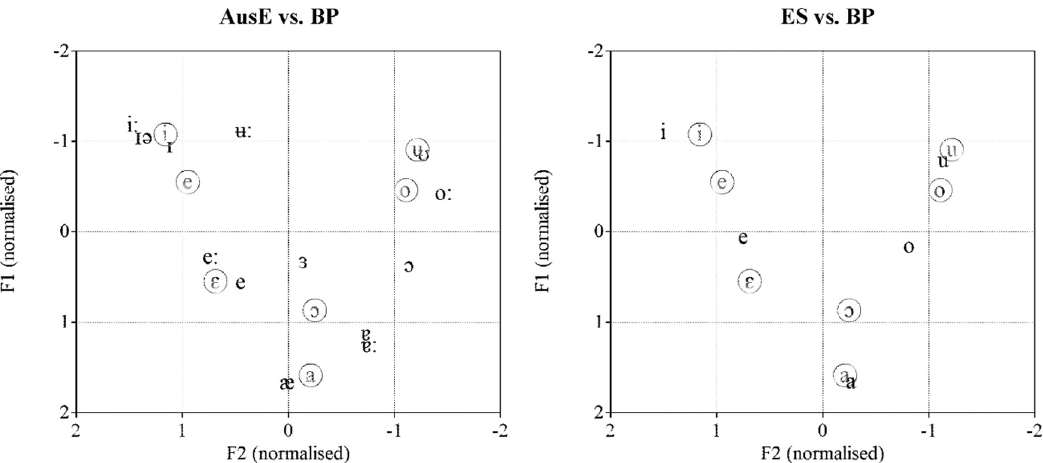
Figure 2. The left panel shows the averaged normalised F1 and F2 values (Hz) for the thirteen AusE 5 (black), and seven BP (gray, circled) vowels. The right panel shows the averaged normalised F1 and F2 values (Hz) for the five ES (black) and seven BP (gray, circled) vowels.